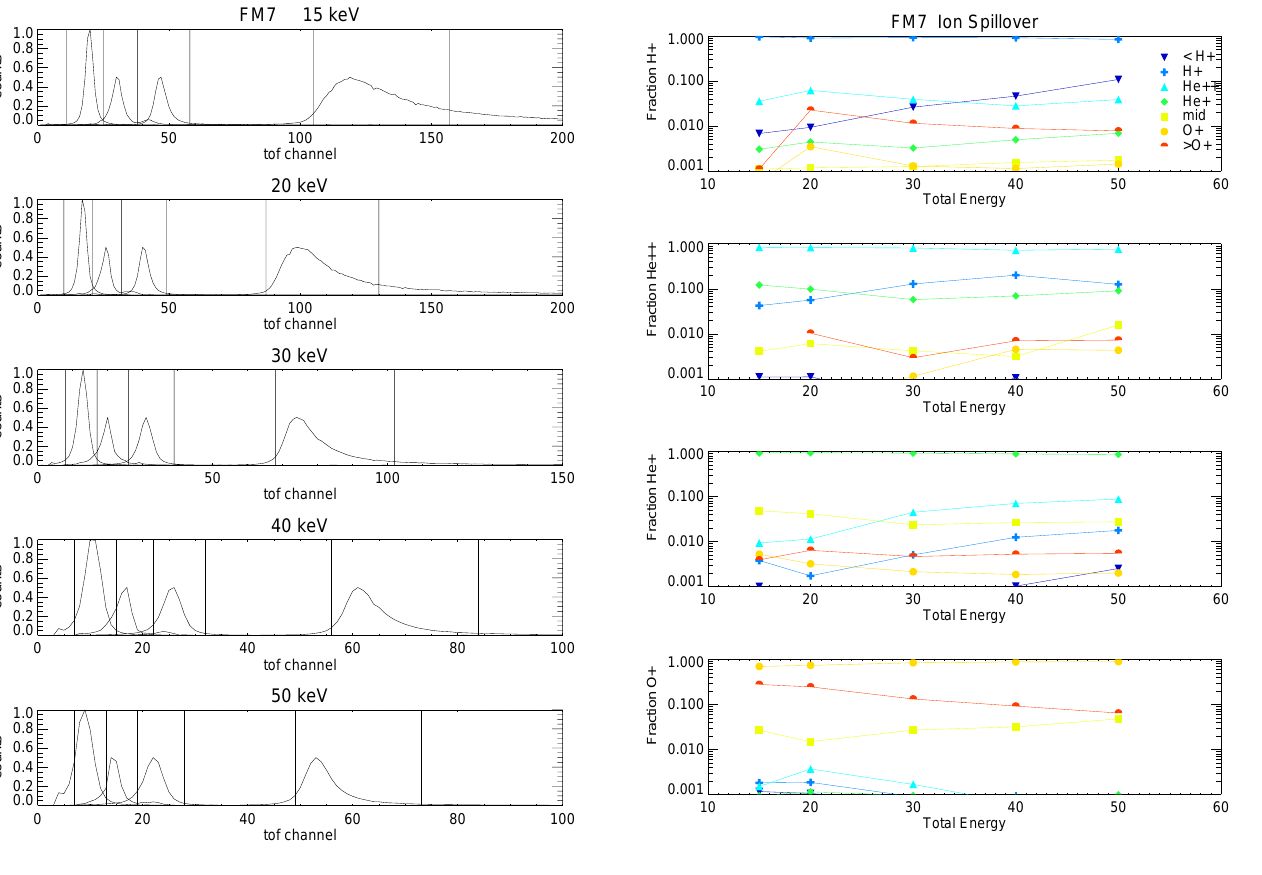
Fig. 17. Example of ion spillover effect in CODIF FM7: fraction of each 4 major ion species detected in the H + , He ++ , He + , and O +